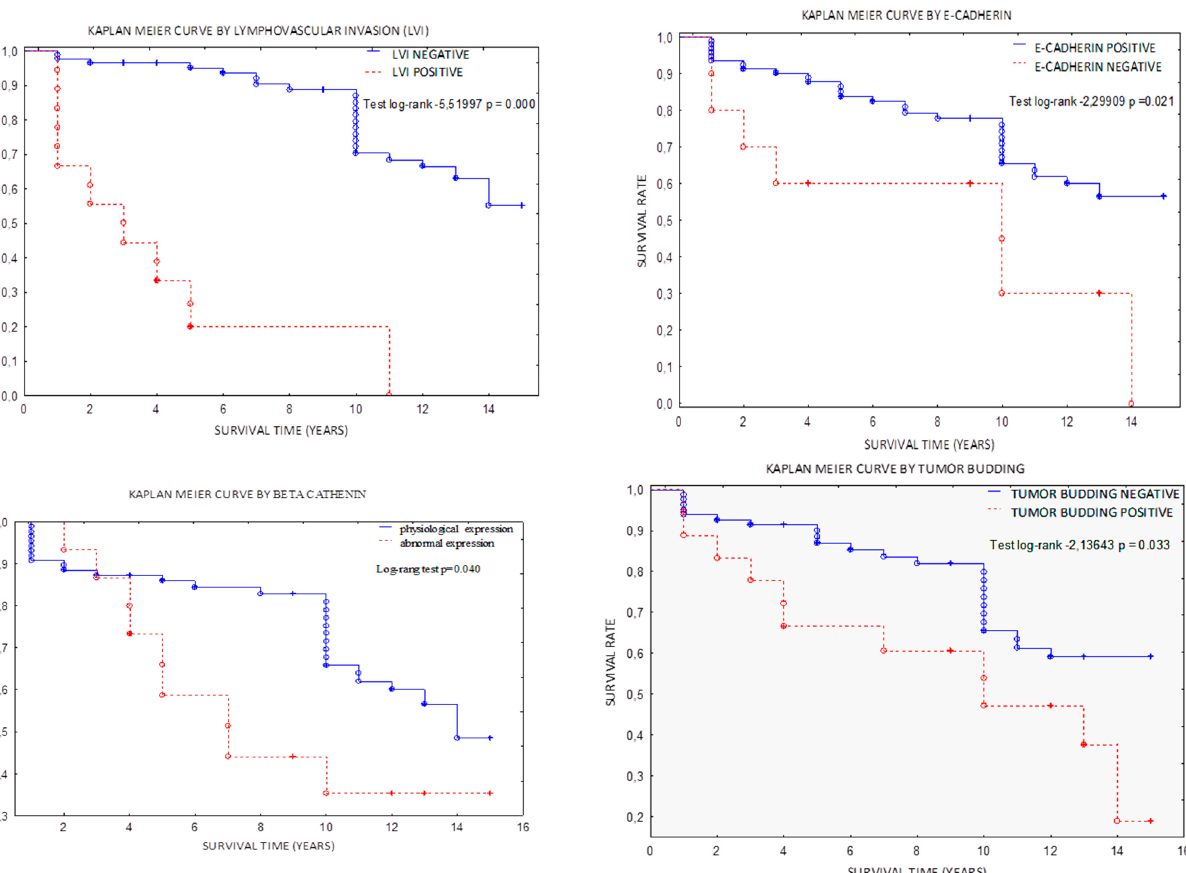
The OS correlation was positive for beta catenin (test log-rank for beta-catenin— p = 0.03977; HR test 0.456, p = 0.041). The Kaplan–Meier curves in Figure 1 present the strongest impacts were caused by LVI+, E-cadherin loss, and tumor budding. The Cox model (Table 4) provided us similar information but multivariant test pointed LVI as the most important one.